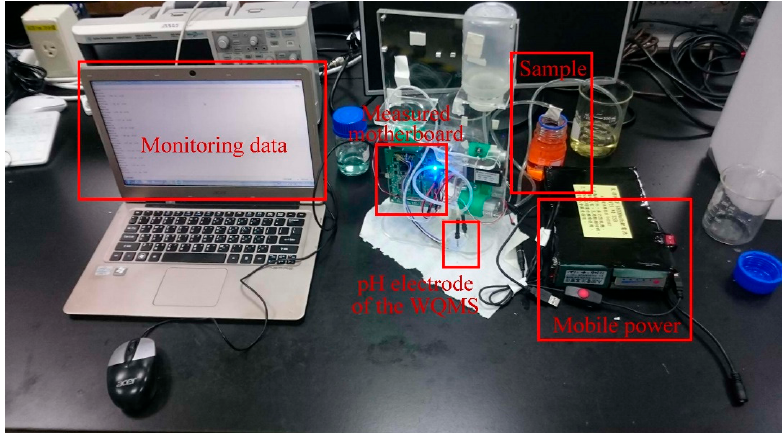
Figure 7. The experimental setup for measuring pH values.